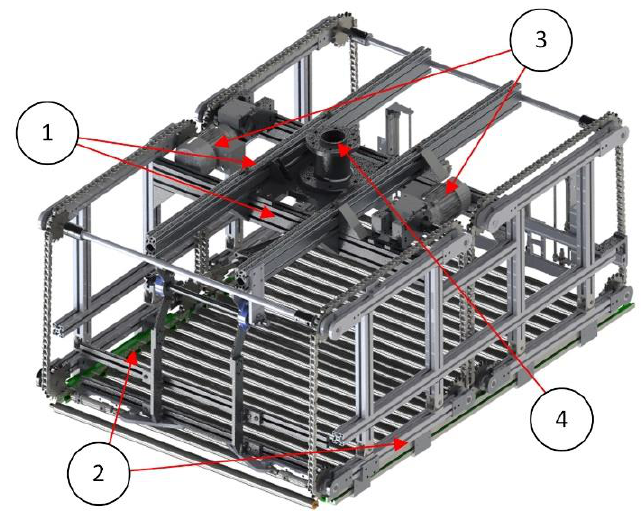
Figure 5. Isometric view of the roller shutter gripper. 1—Base frame, 2—guides with roller shutters, 3—motors, 4—adapter attaching the gripper to the robot flange.